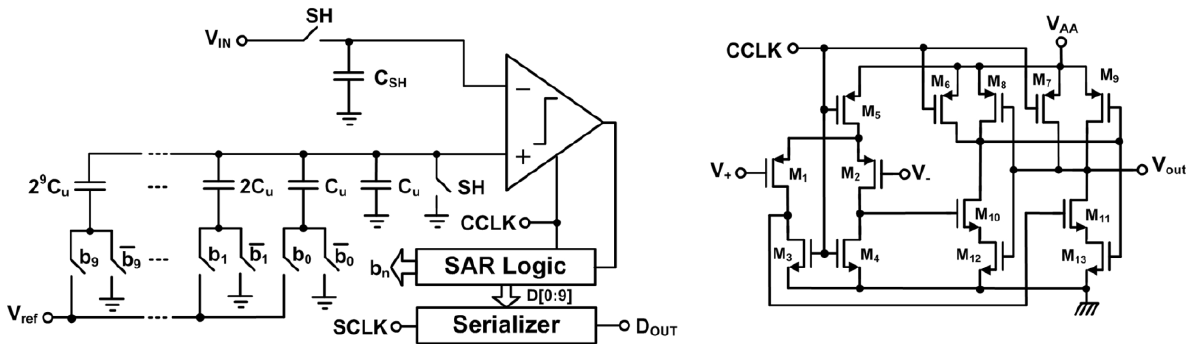
Figure 6. The schematics of the 10-bit SAR ADC and two-stage dynamic